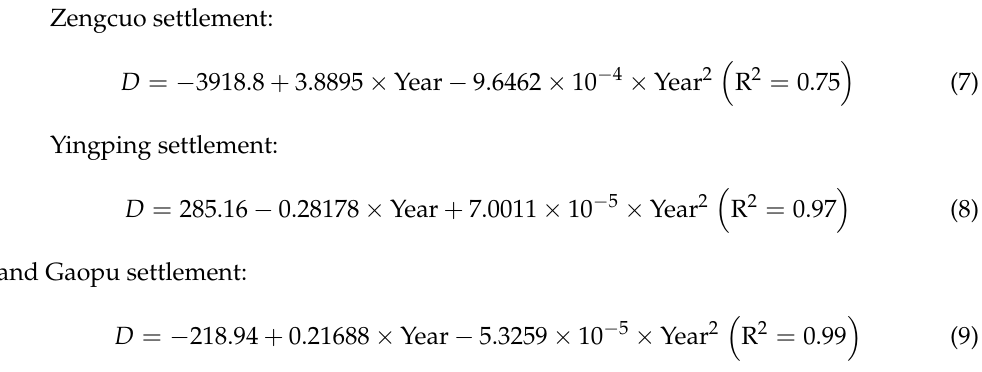
Figure 6. Time evolution of the fractal dimension of Yingping settlement.